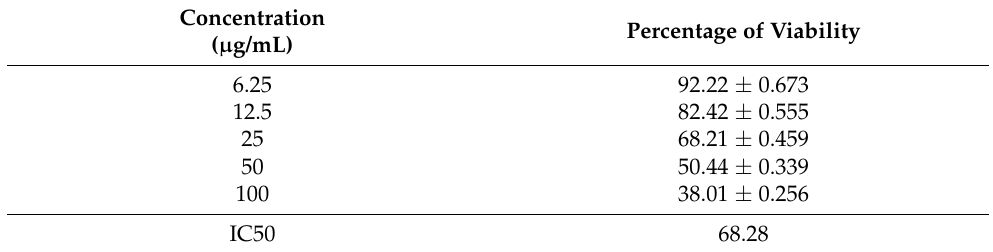
Table 3. Concentration and percentage of viability of APH film and its IC50